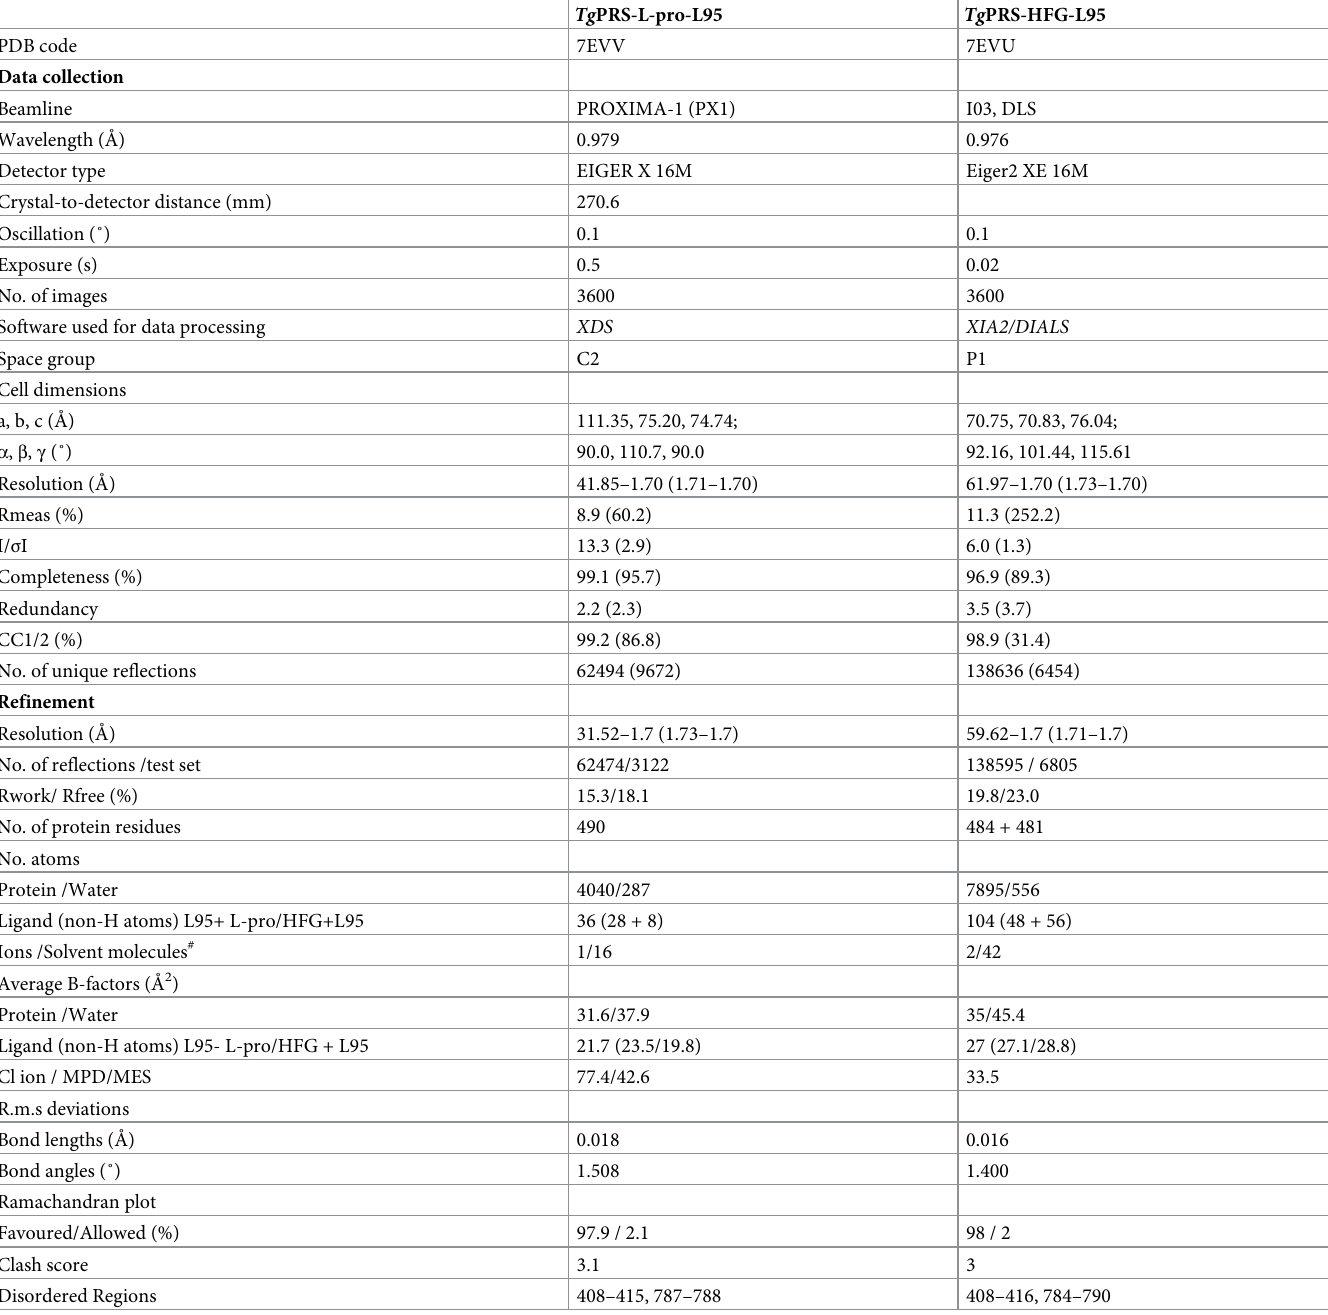
Table 1. Summary of data collection and refinement statistics. Values in parentheses are for the highest resolution